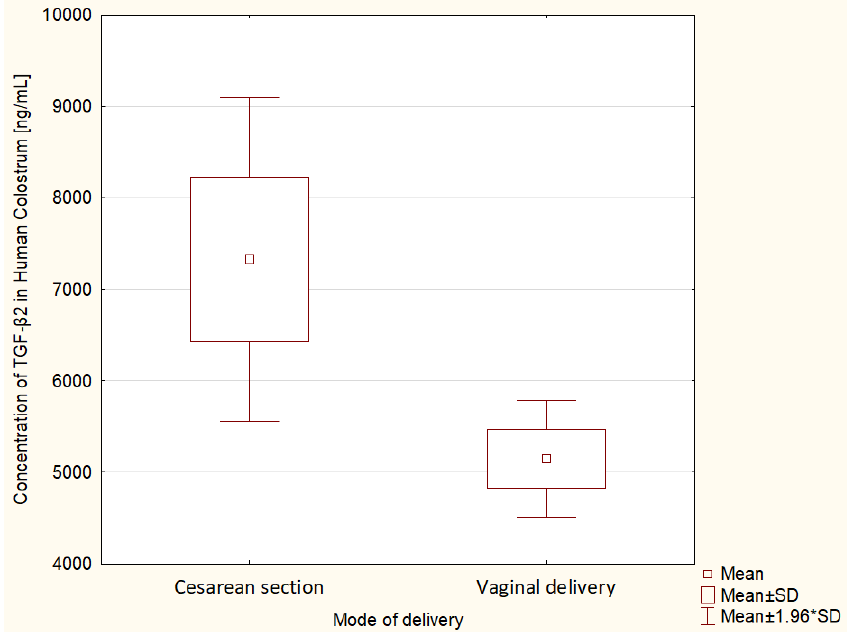
Figure 3. Comparison of mean TGF- β2 values in patients who had delivered at term depending on the mode of delivery.